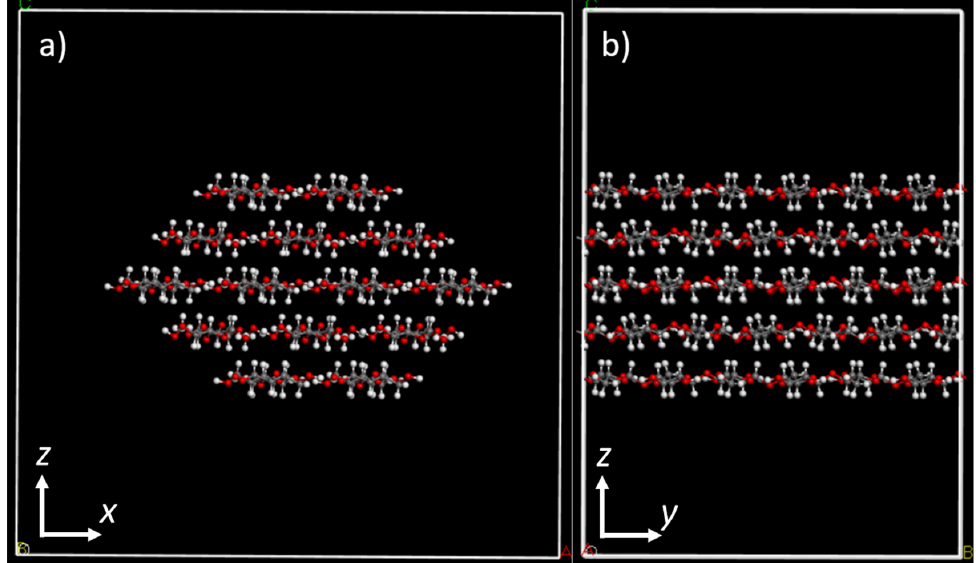
Figure 2. ( a ) Front view and ( b ) side view of a periodic cellulose fibril with 14 cellulose chains and a diameter of 3.33 nm. The dimensions of the simulation box are a : 4.5 nm, b : 3.1 nm, and c : 4.5 nm. The model shown in the figure has 14 × 6 = 84 glucose residues in it.